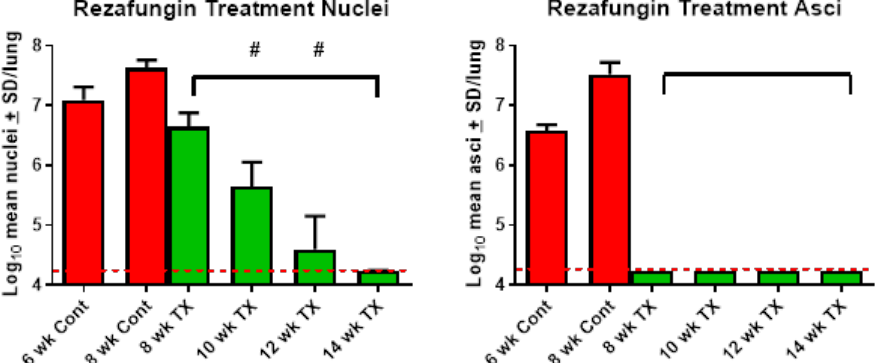
Figure 2. Survival curves for rezafungin and comparators at Week 14 after 56 treatment days of study. CAS = caspofungin; TMP/SMX = trimethoprim/sulfamethoxazole. * Significant difference between rezafungin 20 mg/kg/3 × /week (green line) and CAS (grey line) at week 14 ( p < 0.05).